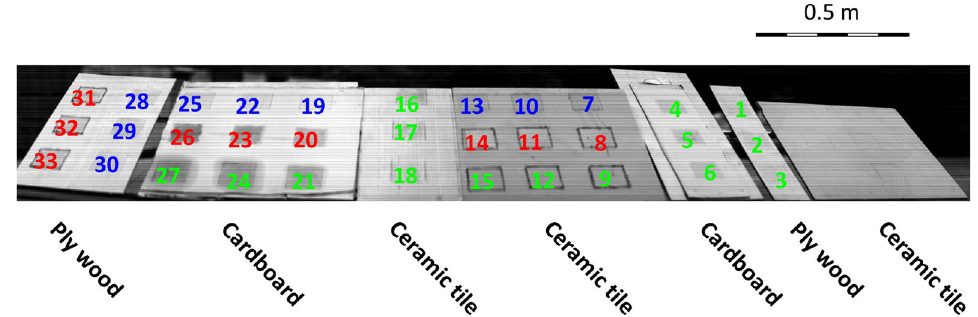
Figure 2. The model set of test targets. Green numbers indicate silicone oil targets; sugar targets are blue, and polystyrene targets are red. Targets 1, 4, 13, 14, 15, 25, 26, 27, 28 and 31 contained 0.5 gr of the target materials,